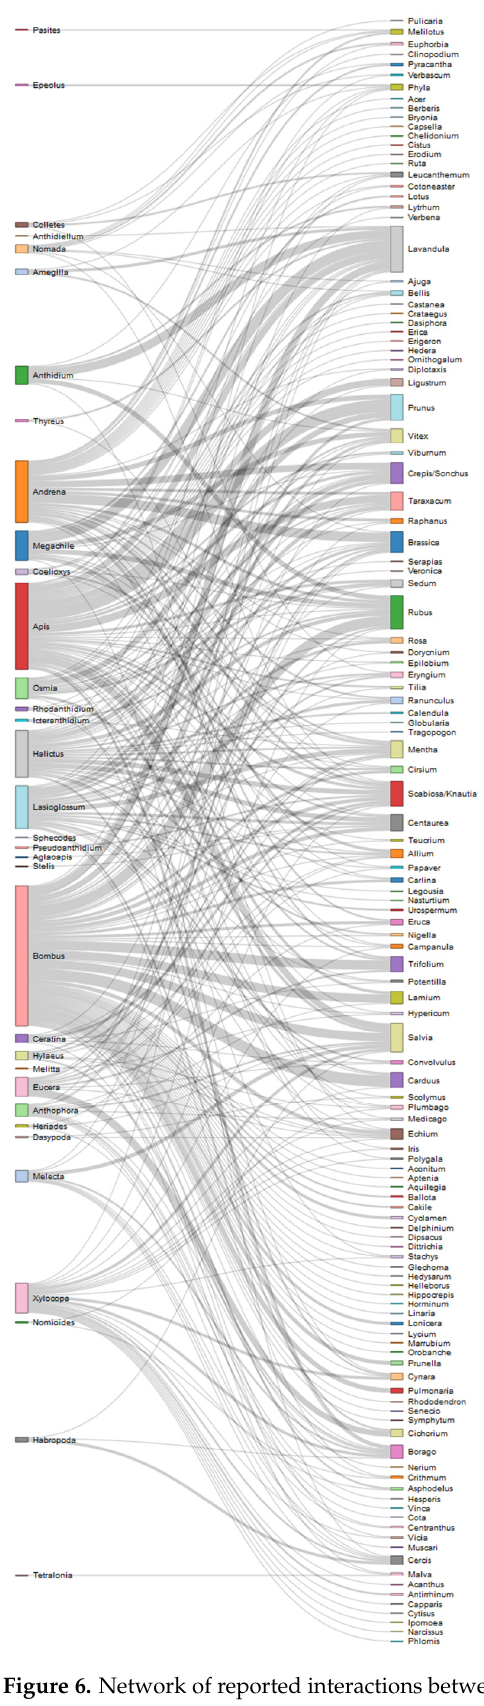
Figure 6. Network of reported interactions between bees and spontaneous plants. Genus taxonomic level is considered. On-line interactive version at.